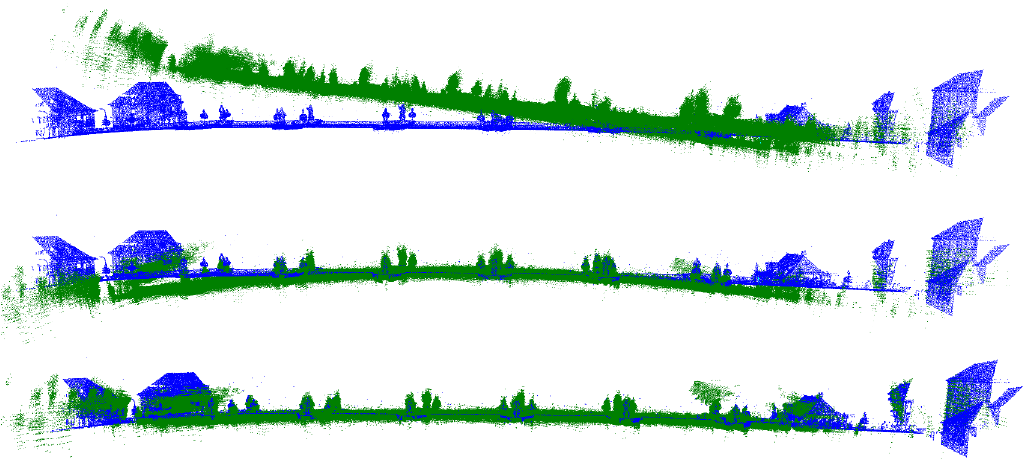
Figure 10. Sideview of ”The Bridge”. Initial (top) and final point cloud without (center) and with Kalman filter initialization (bottom) compared to ground truth (blue). The final point clouds were registered with the ICP implementation from (N¨uchter et al.,